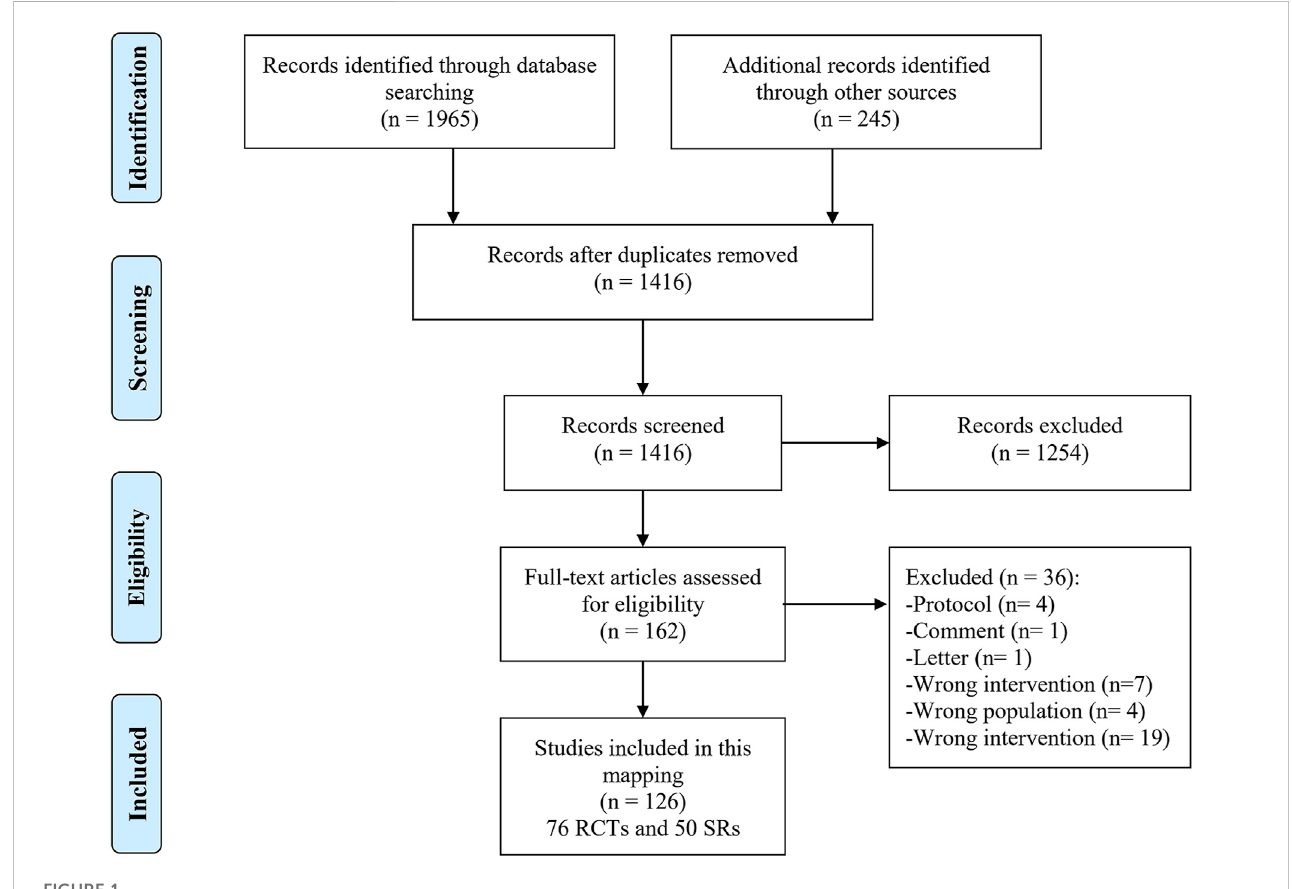
FIGURE 1 Flow diagram representing the process of literature